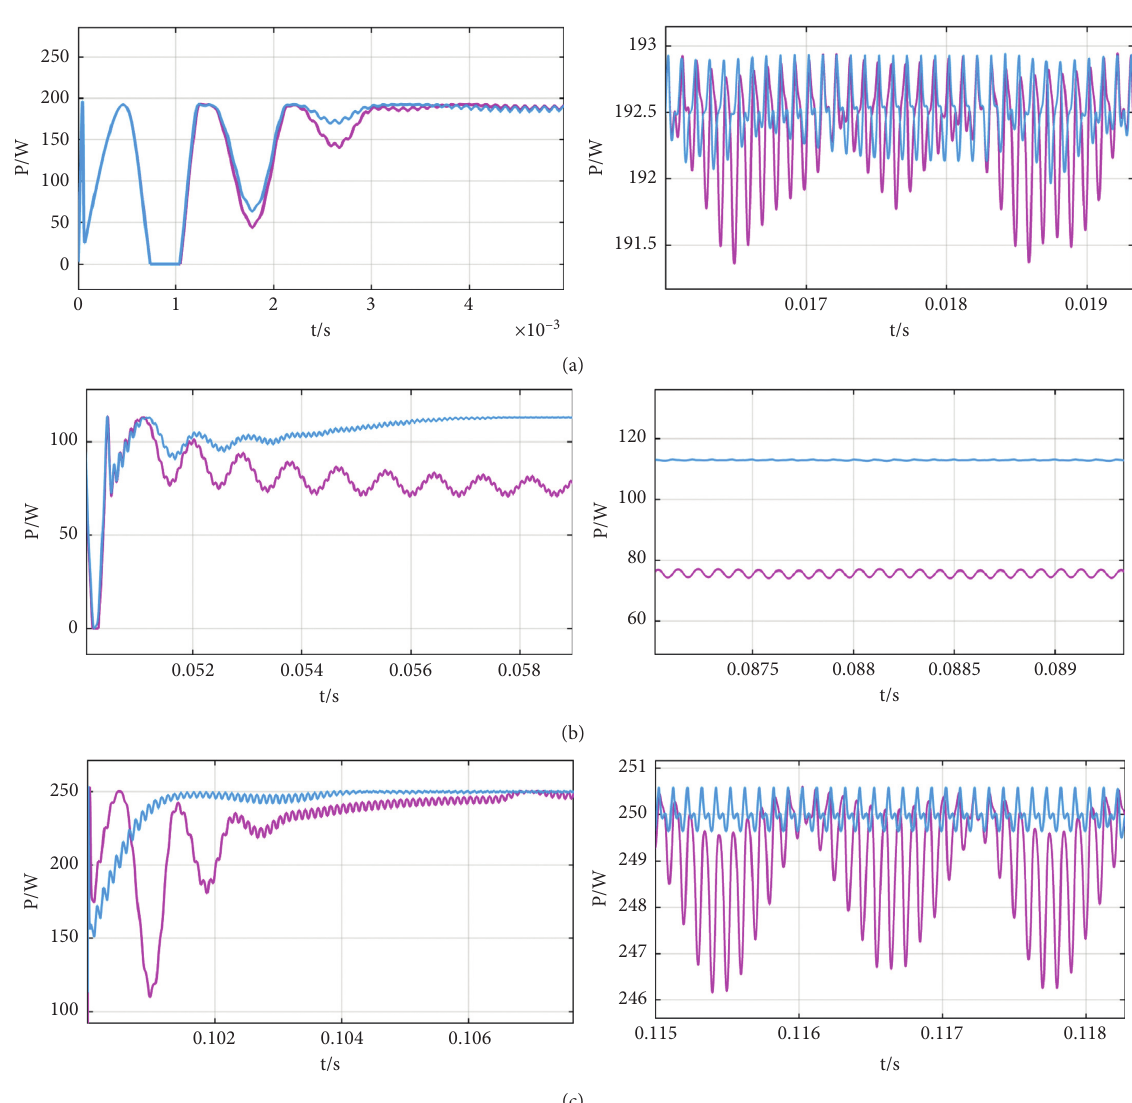
Figure 12: (a) Simulation results of the first stage. (b) The second stage simulation results. (c) The third stage simulation results.